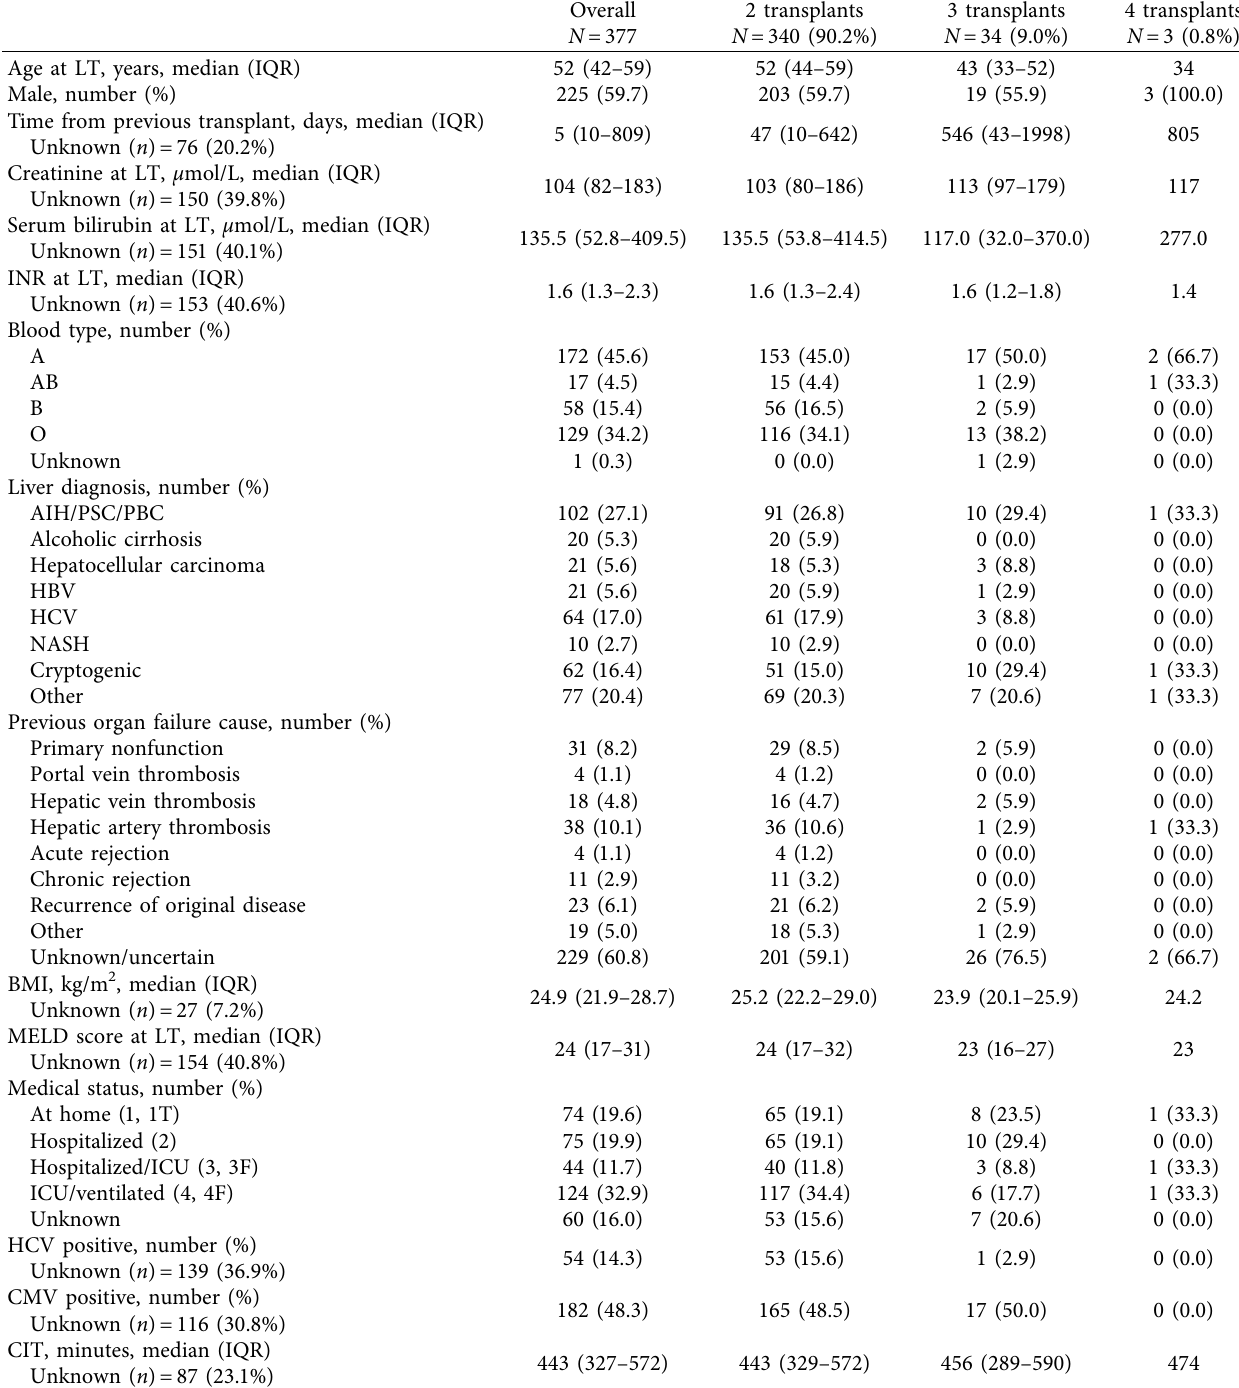
Table 1: Liver retransplant recipient